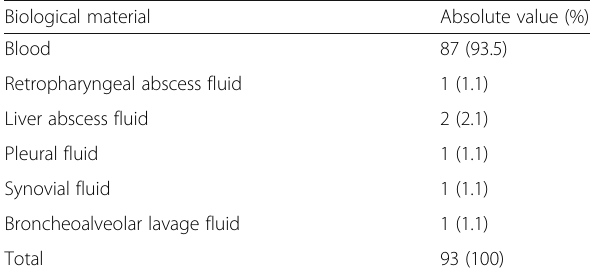
Table 2 Biological samples from which microorganisms were isolated in 93 patients who used probiotics Biological material